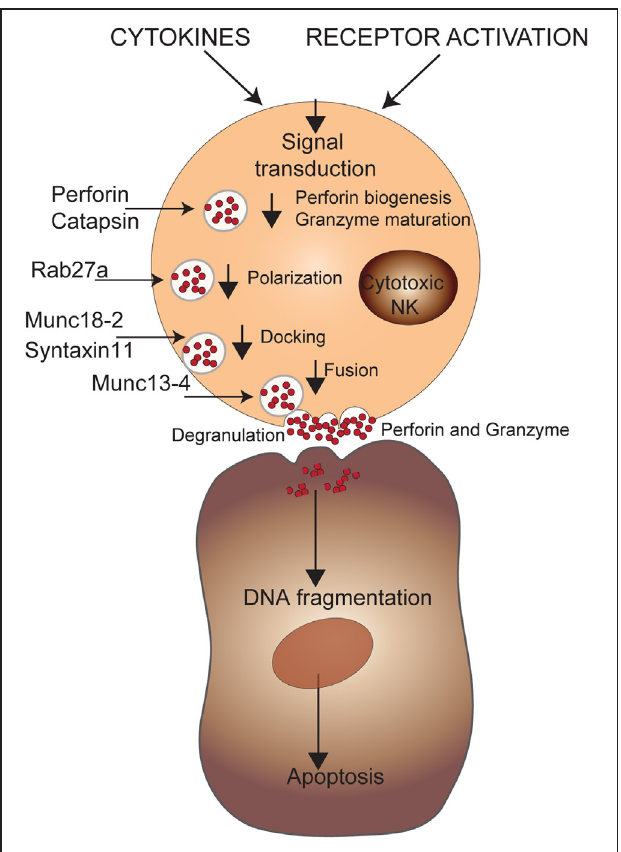
FIGURE 5 | Genetic defects in NK cell cytotoxicity. NK cell effector functions are triggered through activating receptors and/or cytokines. A cascade of intracellular events will induce the biogenesis of perforin and maturation of granzyme B that will be secreted via cytotoxic granules leading to apoptosis of target cells via DNA fragmentation. The mutations affecting maturation of the cytotoxic granules or their transport to the cell membrane are